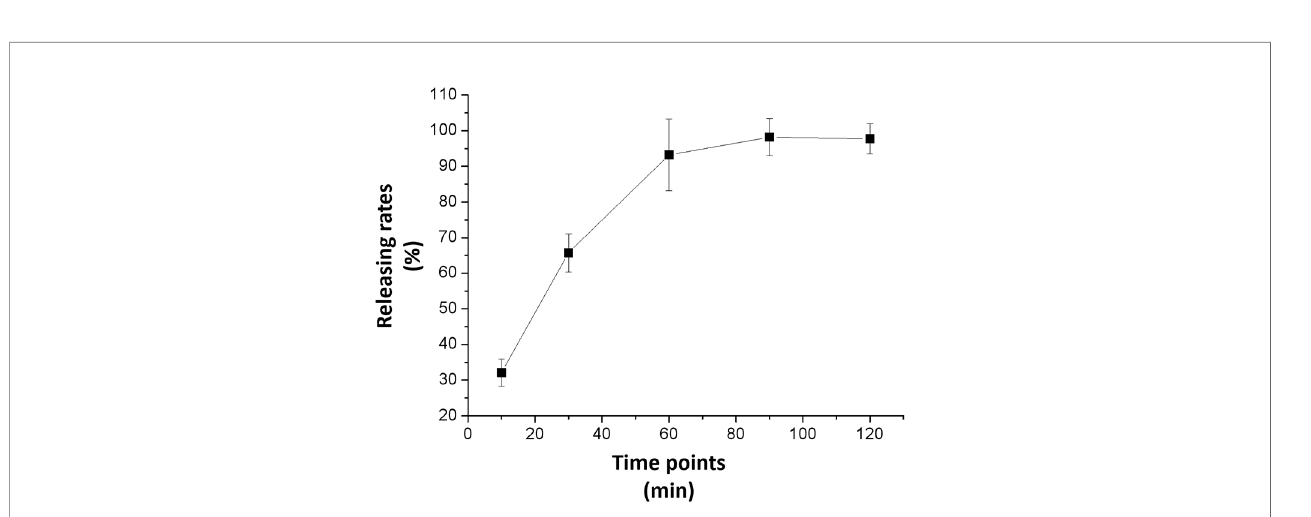
FIGURE 3 | In vitro release from the anlotinib nanocrystal. The results are shown as line-chart images. The abscissa (X-axis) shows the releasing time points (min) and the ordinate (Y-axis) shows the releasing rates (%).